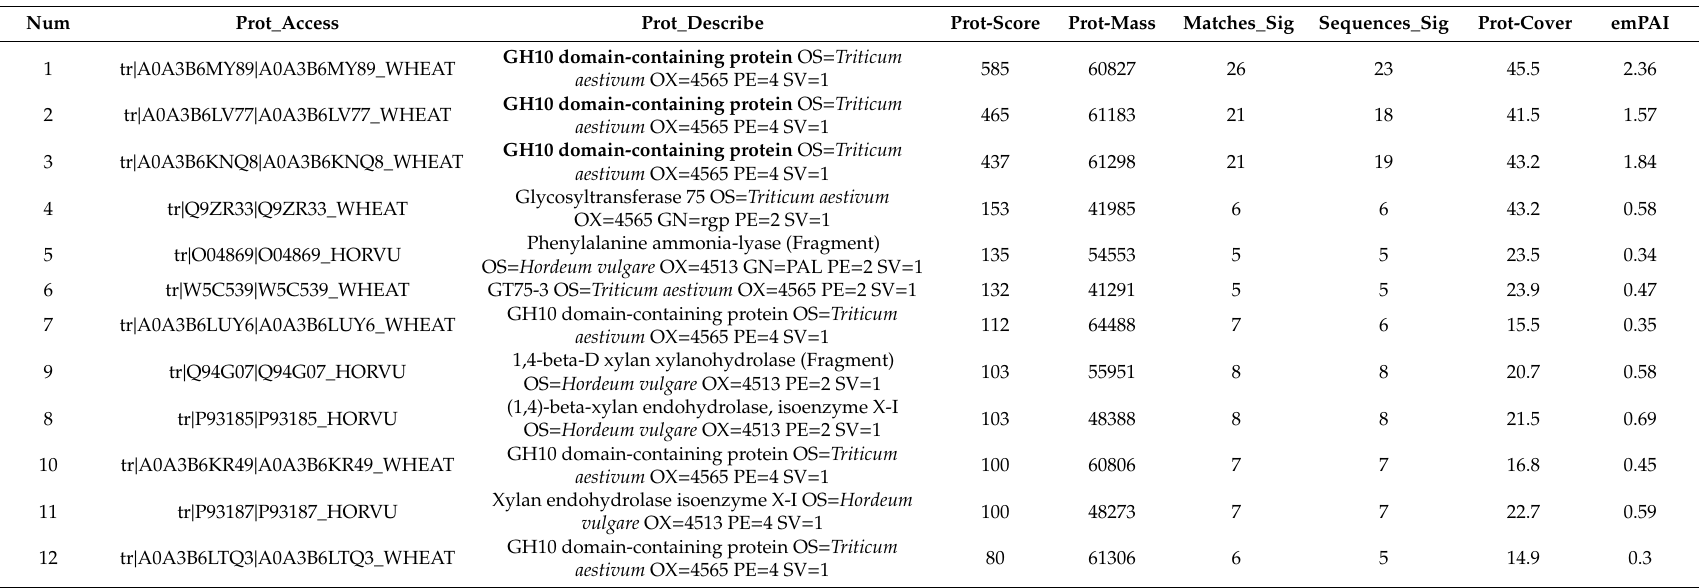
Table 2. The matched protein information of LC–MS /